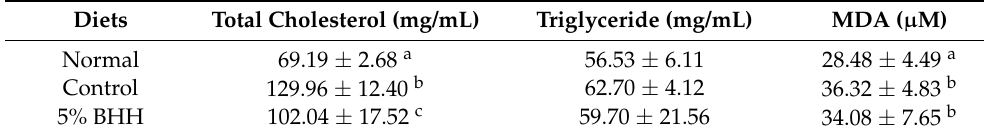
Table 2. Total cholesterol, triglyceride, and MDA levels in mice fed normal diets (Normal), high-fat